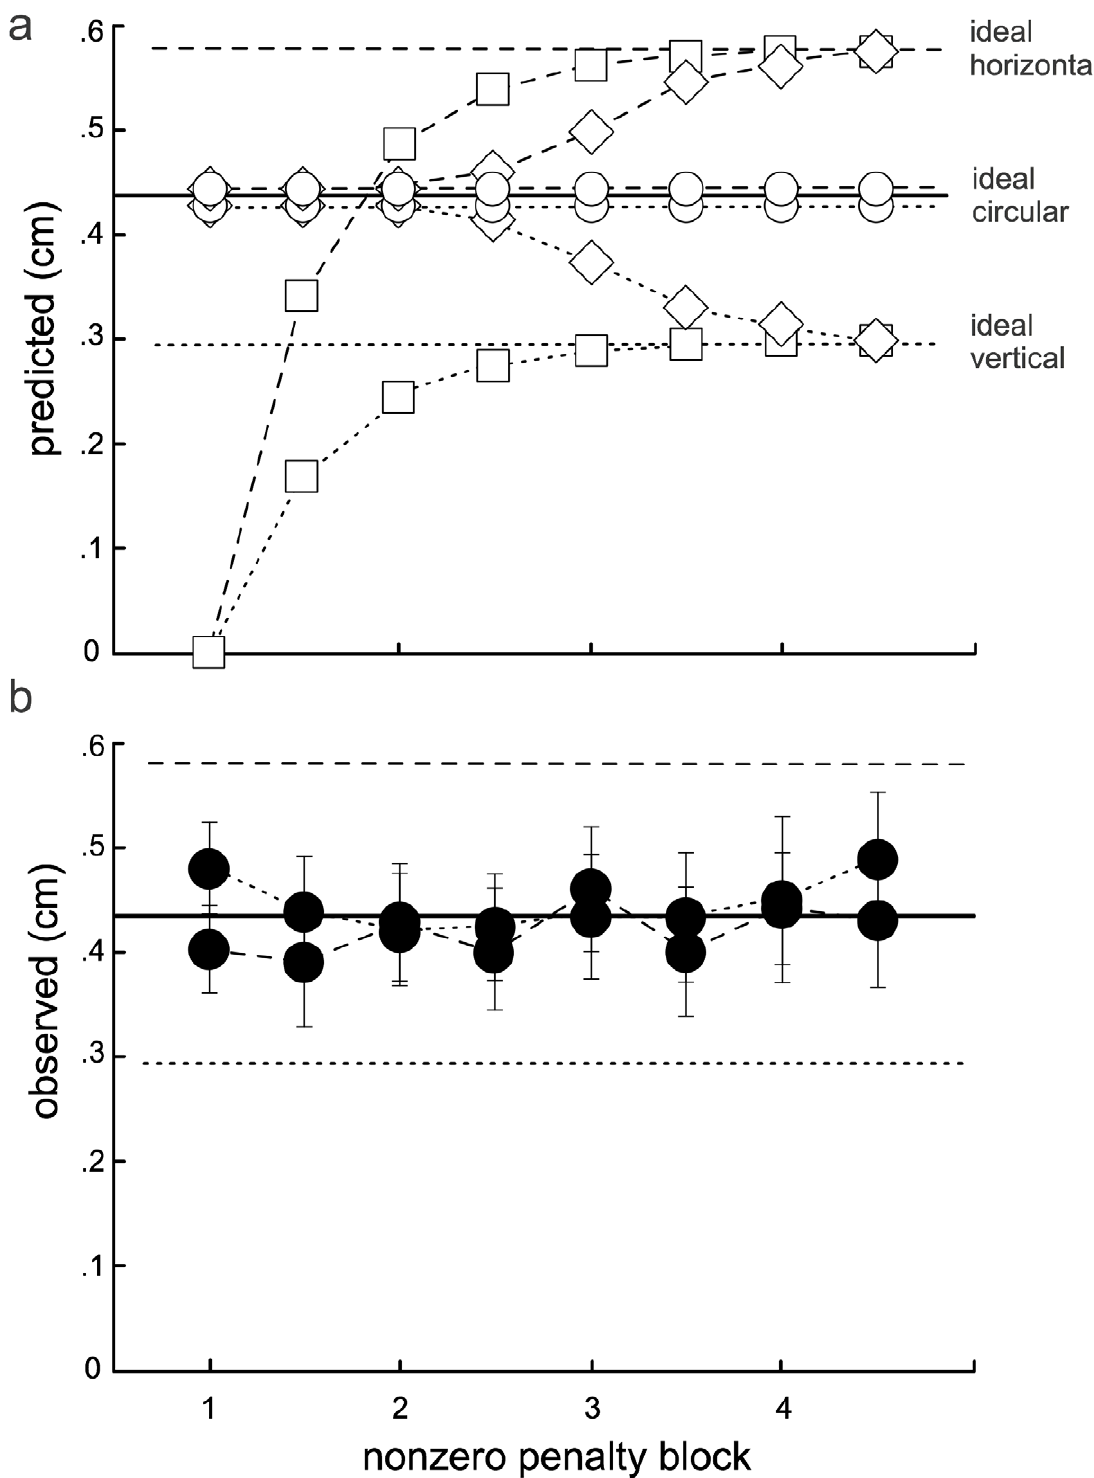
Figure 7. Time course of nonzero-penalty aimpoints. a , Hypothetical data. Circles: aimpoints based on a stable internal model of endpoint variance using error magnitudes only. Diamonds: based on a process that has formed a circular model of endpoint variance as a transitory first step, but continues to update this model throughout training. Squares: based on a hill-climbing process responding solely to rewards and penalties. b , Time course of observed D aim values. Data are averaged over successive half-blocks of the 4 nonzero-penalty blocks (separating horizontally or vertically oriented target-penalty pairs), collapsed across subjects. Each subject was presented with 4 nonzero-penalty blocks and 2 zero-penalty blocks. These blocks occurred at different points in the experiment for different subjects. There is no hint that the two time courses diverge at any point during experiment.